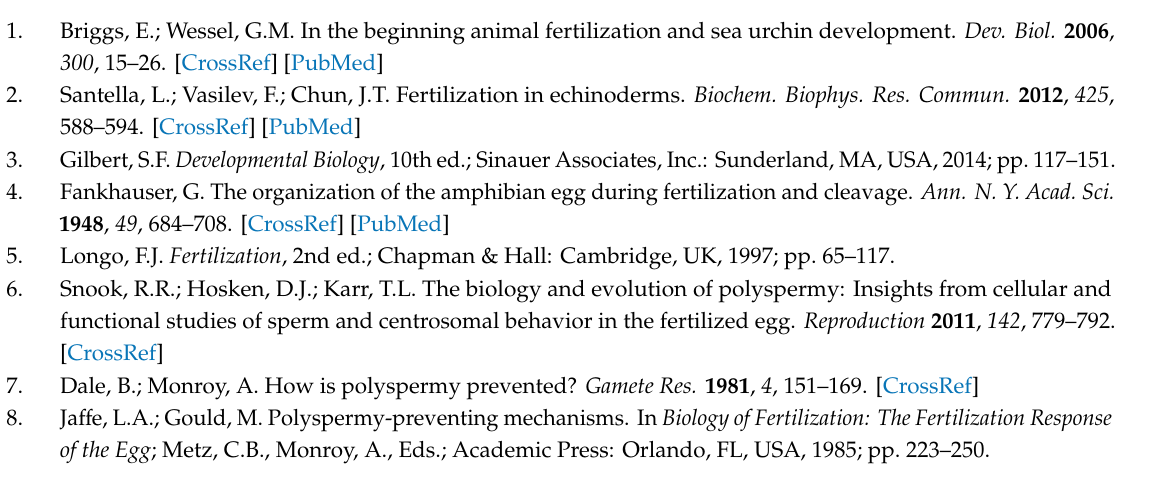
Figure S1: A high dose of nicotine induces massive polymerization of cortical actin cytoskeleton in sea urchin eggs within a few minutes of incubation. Figure S2: Competitive antagonists of nAChR do not inhibit nicotine-induced polyspermic fertilization. Figure S3: Nicotine induces both cortical F-actin changes and polyspermy in starfish eggs. Video S1: Movements of F-actin in the control eggs at fertilization. Video S2: Movements of F-actin in the nicotine-pretreated (20 mM, 5 min) eggs at